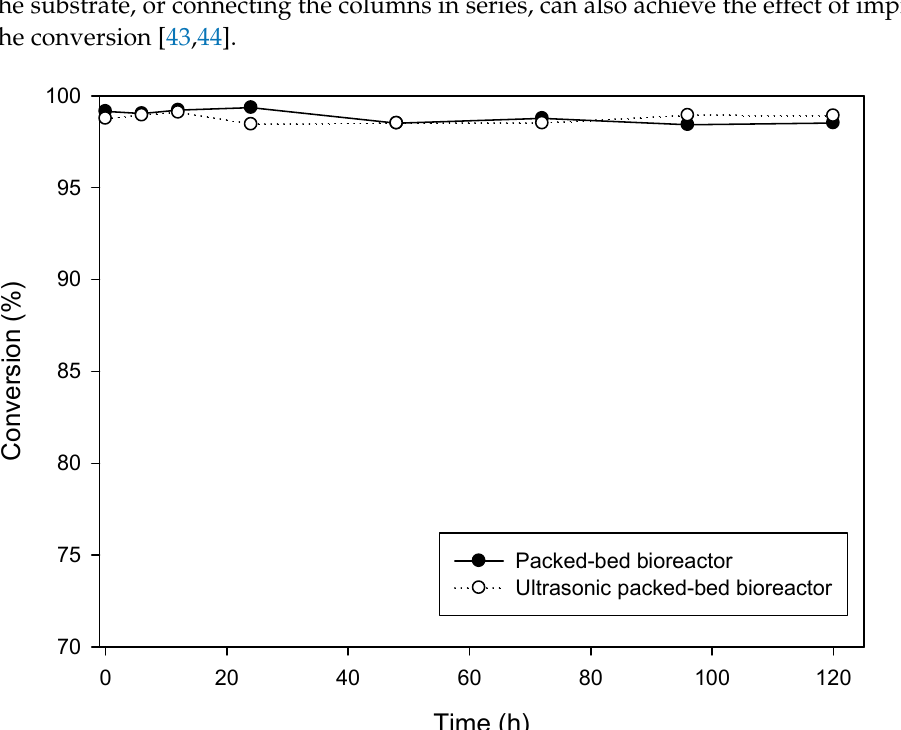
ultrasonic packed-bed bioreactor (cid:35)